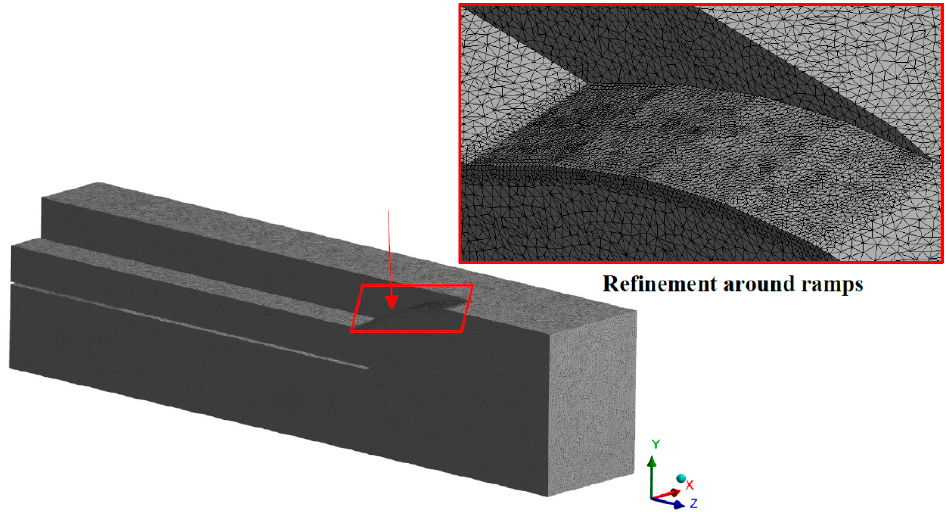
Figure 28. Computational domain 3-D mesh and refinement.